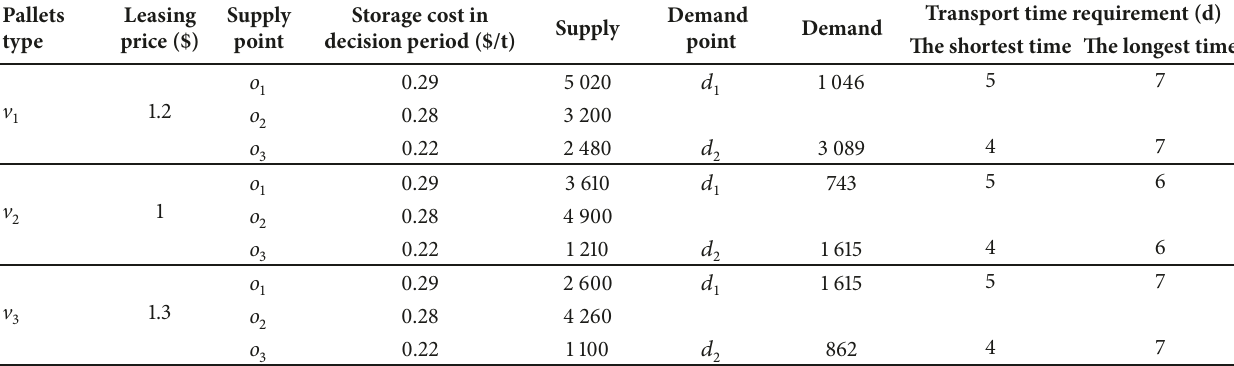
Table 1: Parameters of supply and demand.